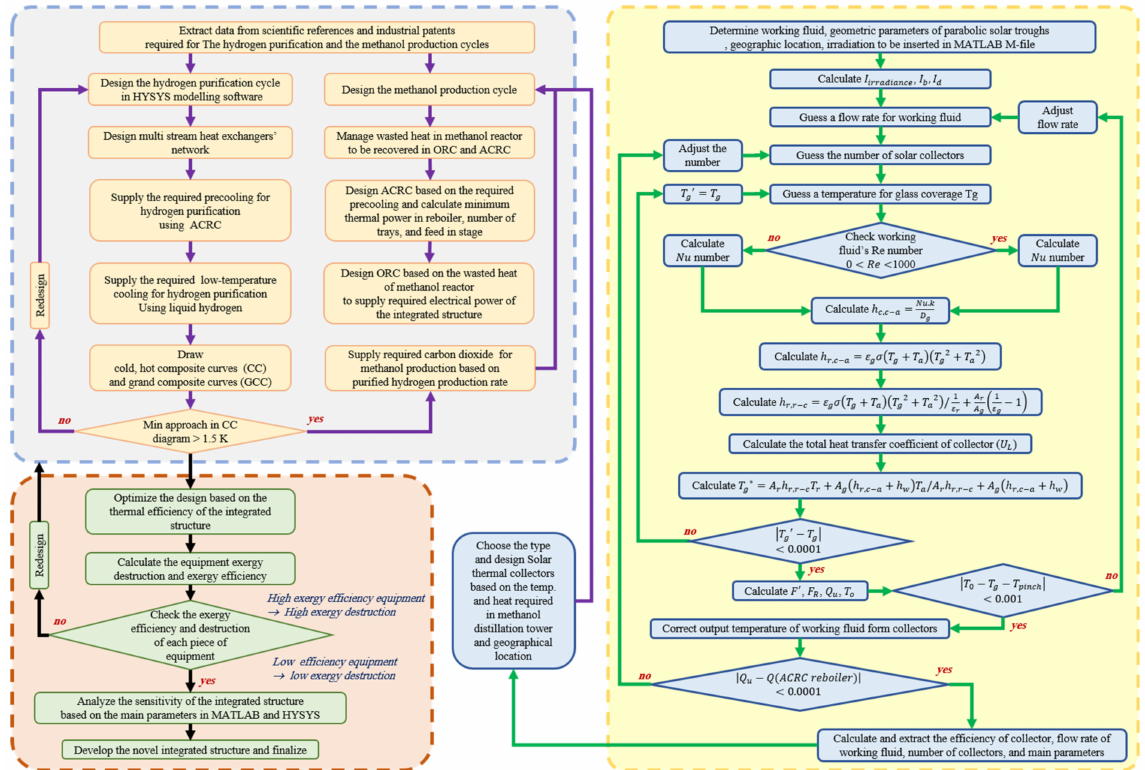
Figure 3. The algorithm of the design and development of the novel integrated